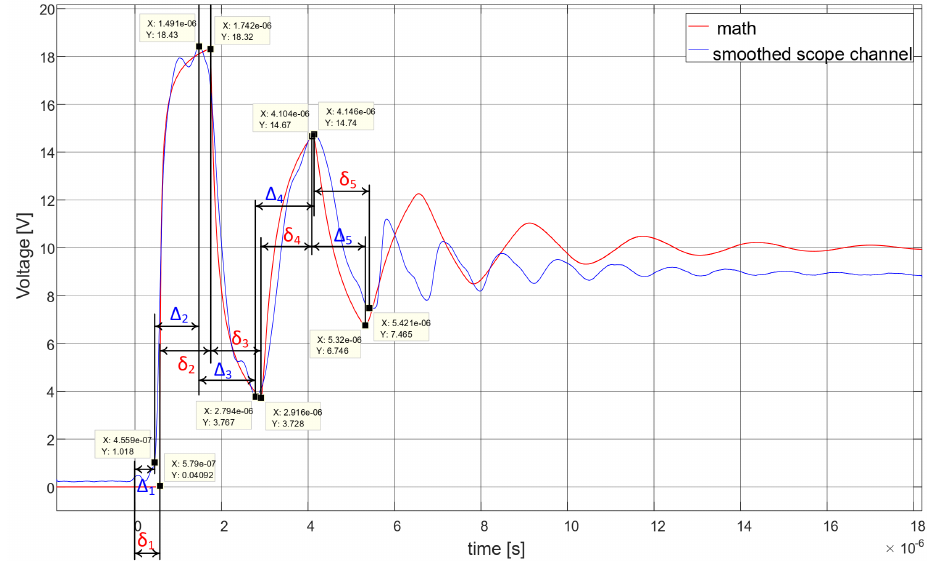
Figure 32. Comparison results between Equation (105) and the smoothed scope